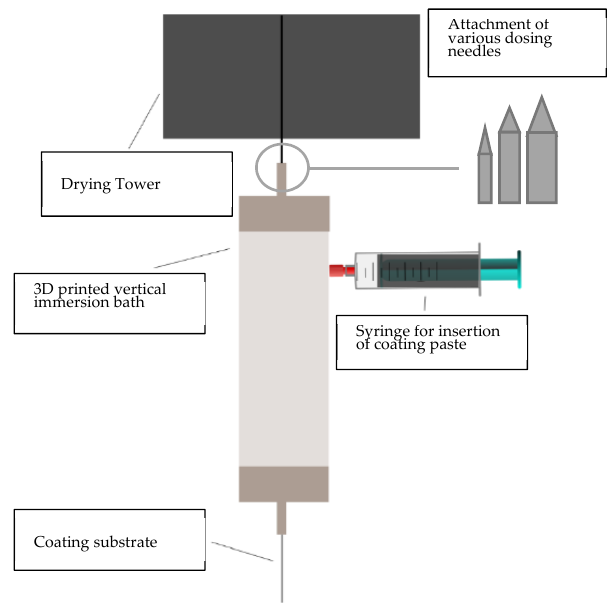
Figure 2. Schematic drawing of coating Figure 1. Schematic drawing of coating set-up.